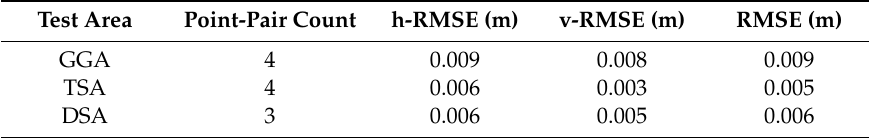
Table 4. The root mean square errors (RMSEs) in each UAS imagery used in this study.